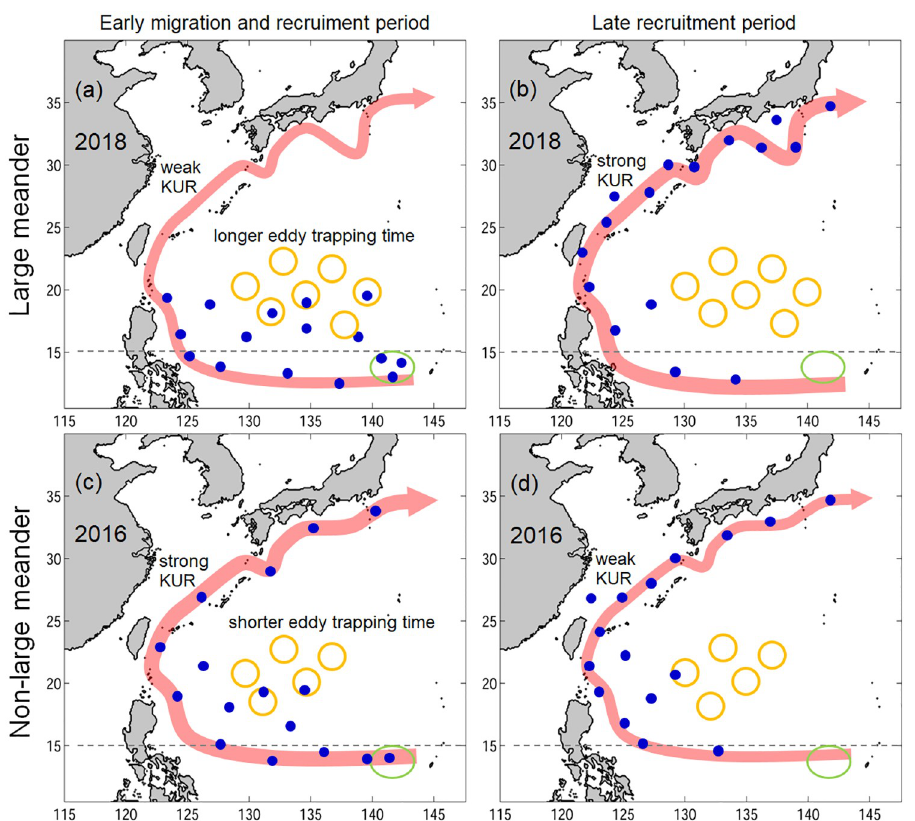
Fig 9. Schematic diagram illustrating the ocean conditions and v-larvae distributions for the 2018 large meander (a,b) and 2016 non-large meander (c,d) years during the early migration and recruitment season (a, c), and late recruitment period (b, d). Yellow circles represent eddies, blue dots represent v-larvae, the width of the red shading arrows reflects the strength of the Kuroshio (KUR), and green circle marks the spawning area in the North Equatorial Current (NEC). The dotted line enables comparison of the relative position of the